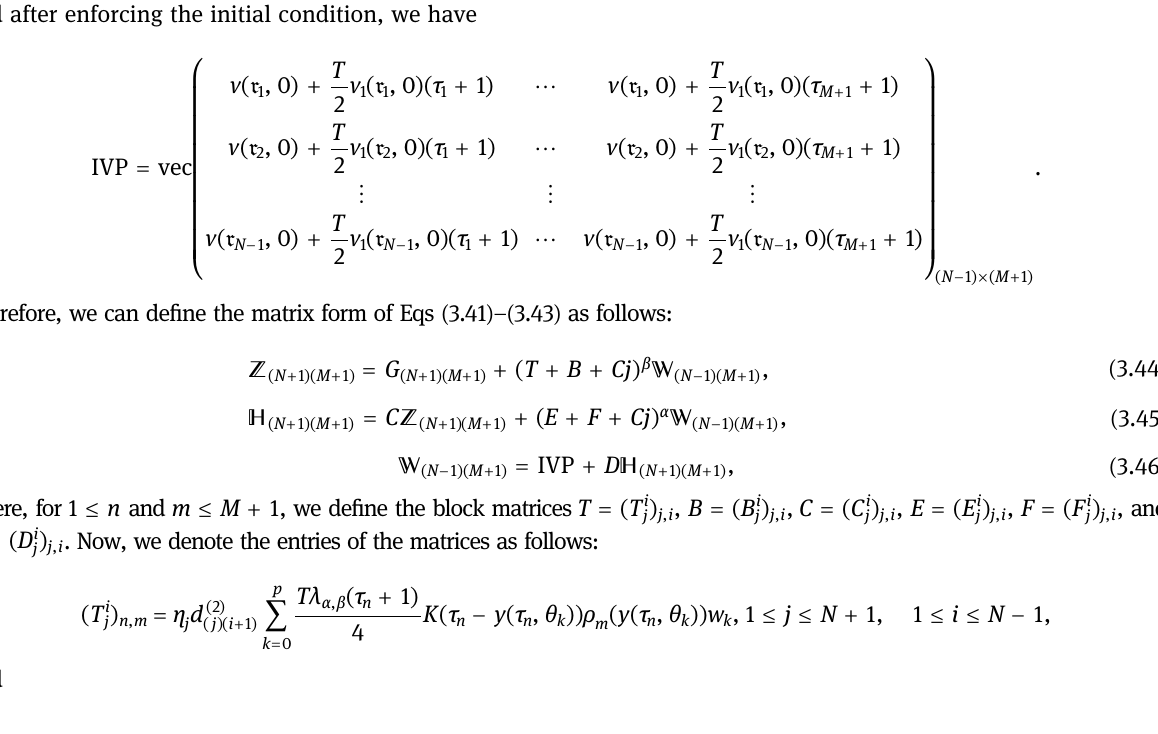
Table 1: The errors E ∞ ‖ ‖ obtained for Example ( 4.1 ) with RSMs and SM, when α 1 = and β 1